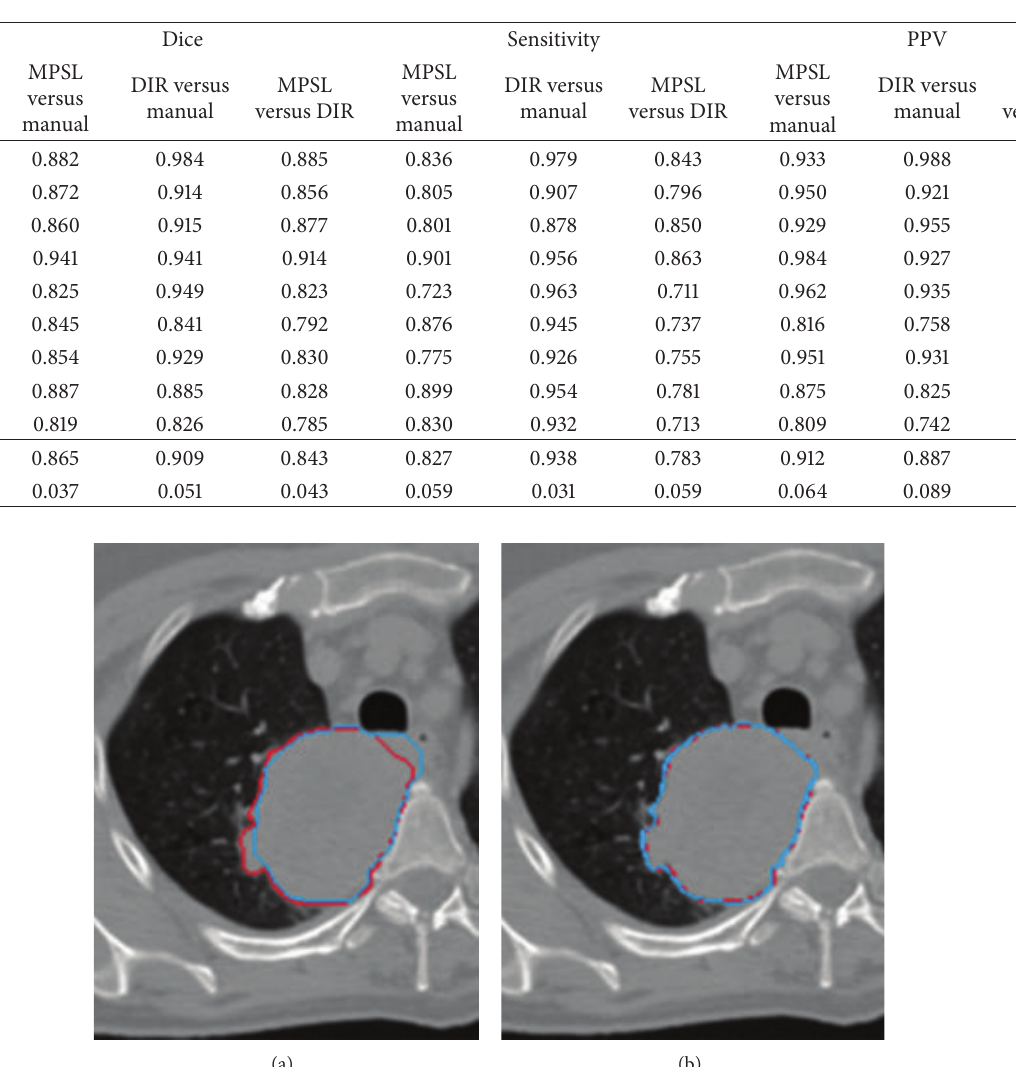
Table 1: Dice similarity coefficients, sensitivity, and PPV between GTV contours generated with the proposed MPSL method and DIR based segmentation.